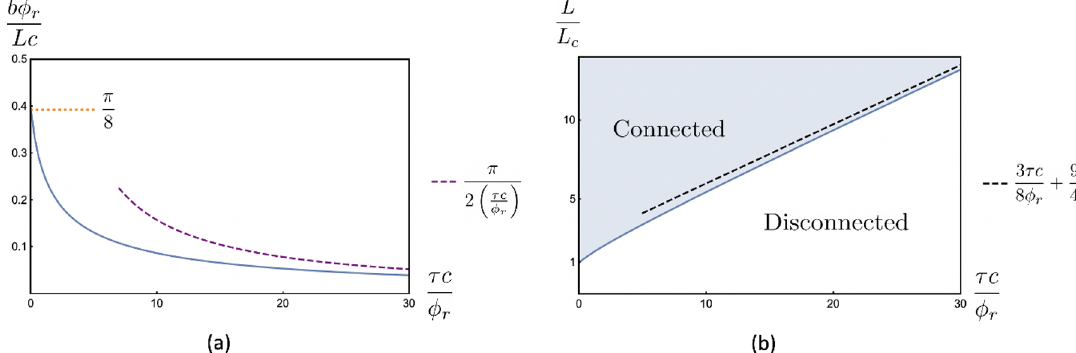
with respect to τc coming from solving (3.29). We Lc φ r . The blue shaded region is the φ r